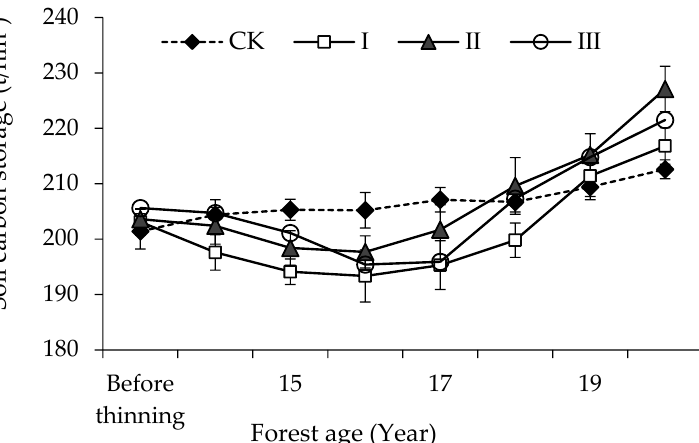
Figure 6. Dynamic variation of soil carbon in C. lanceolata plantation under different thinning intensities.